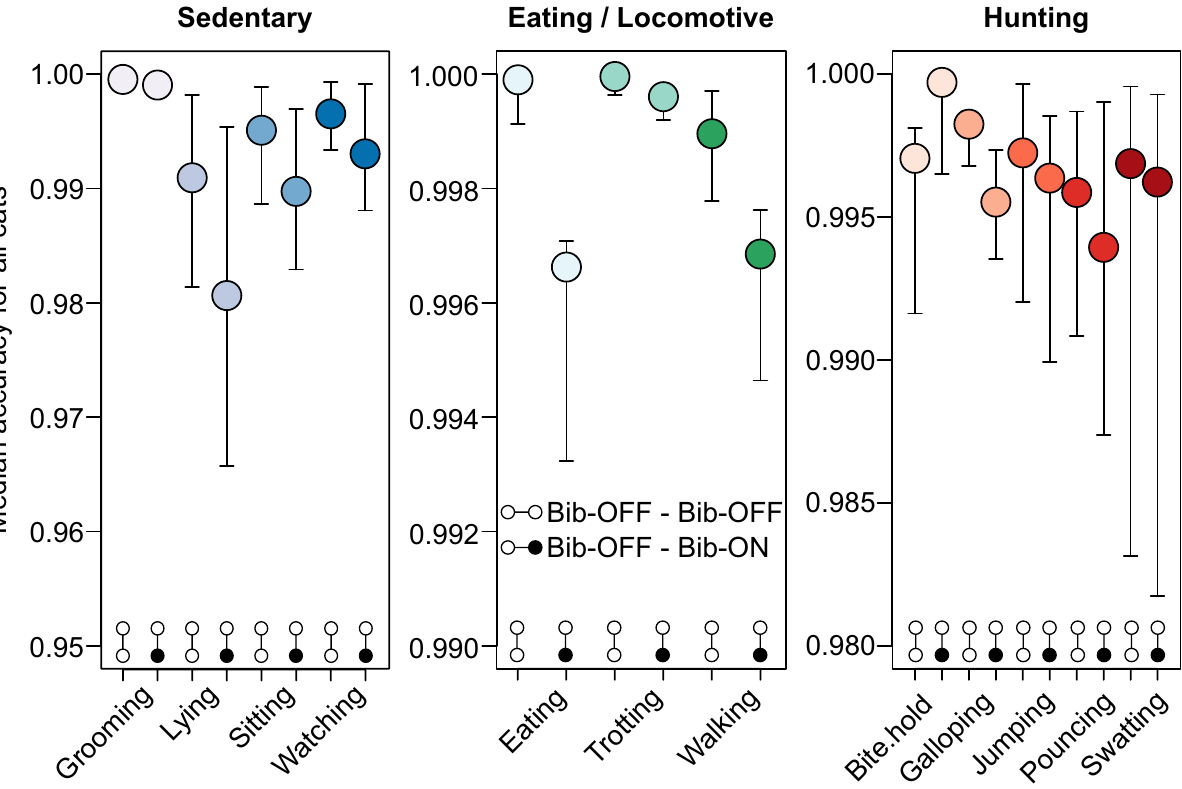
Figure 4. The prediction accuracy of the SOM trained with a random sample of 20,000 1-s epochs of Bib OFF data for all cats to predict either Bib OFF (n = 231,570) or Bib ON samples (n = 175,989), separated by activity. Colours represent grouped behaviours, with sedentary activities represented by blue colours, eating and locomotive by green and hunting activities by red. Within each activity, we interpret changes in predictability as modifications in the accelerometer signature in response to the cat